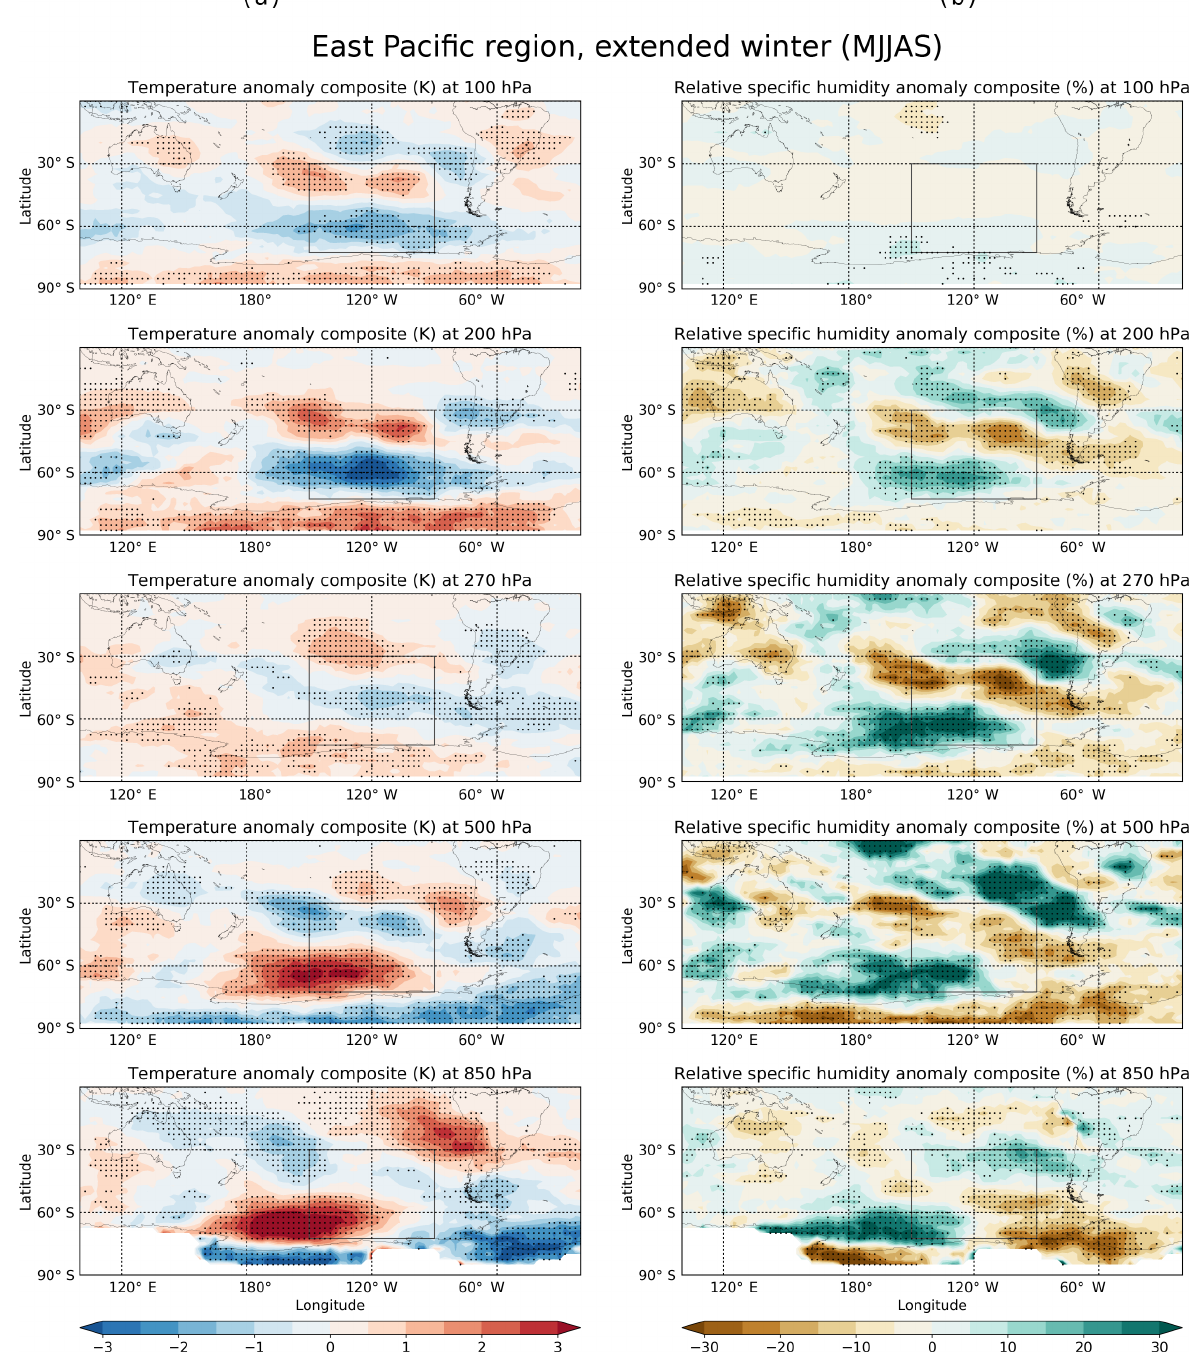
Figure 8. As Fig. 5 but for the southern hemispheric extended winter (MJJAS) shown for blocking in the East Pacific region between 150–90 ◦ W and 72.5–30 ◦ S (81 days in